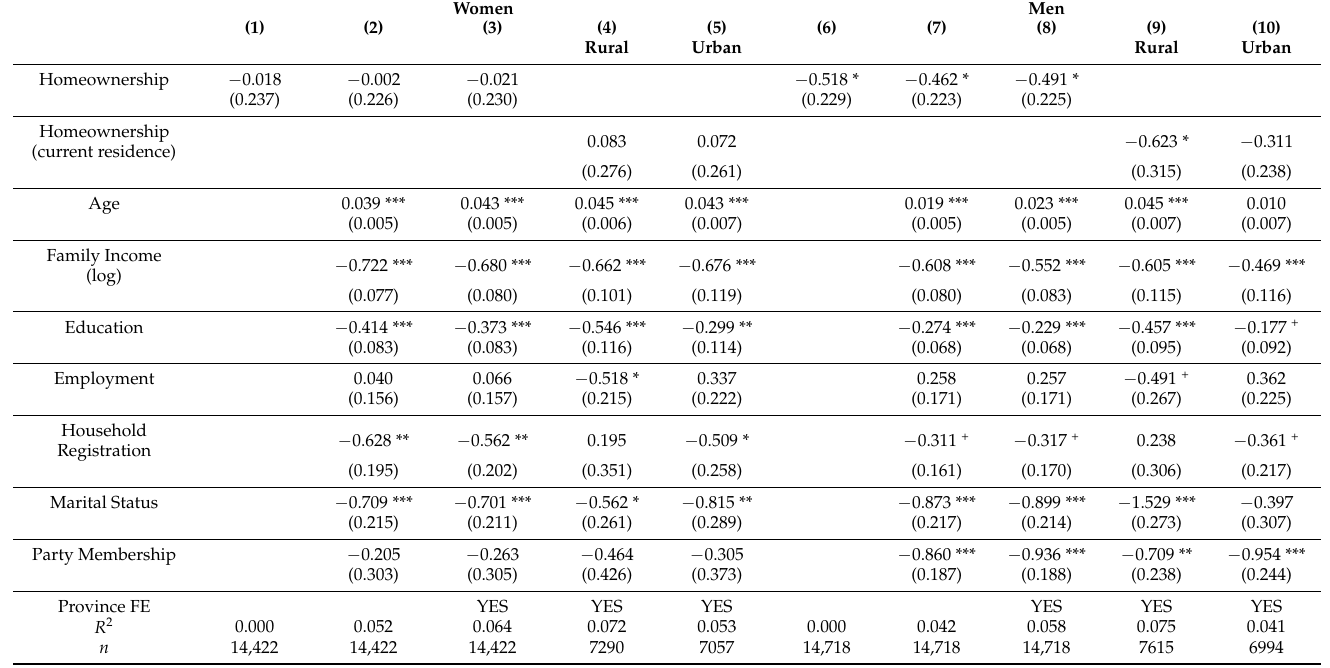
Table 2. Homeownership on Depression (cross-sectional weights).